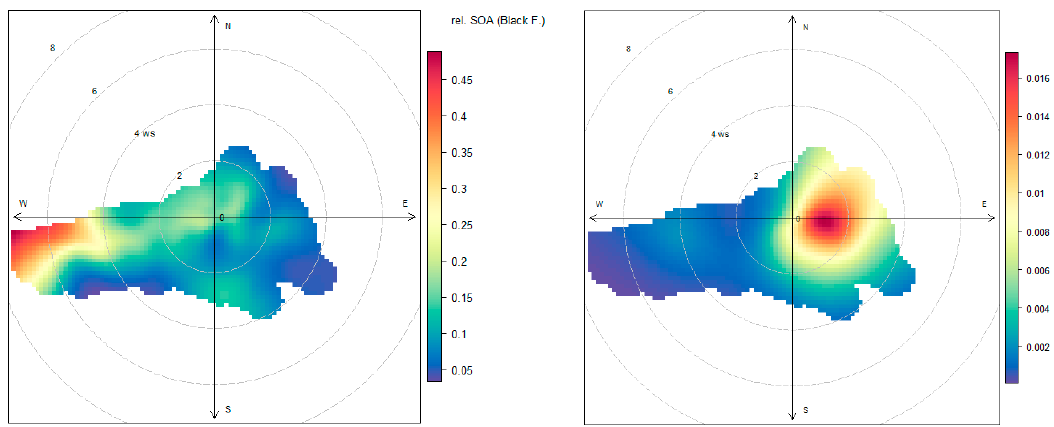
Figure 5. Changing forest ecosystem composition (Alsatian Vosges forest to Black Forest) and its consequences for ambient SOA mass concentrations. Left : intensities of calculated SOA as a function of wind speed and direction at Muenstertal; Right : absolute calculated SOA difference in µg/m 3 as a function of wind speed and direction at Muenstertal.